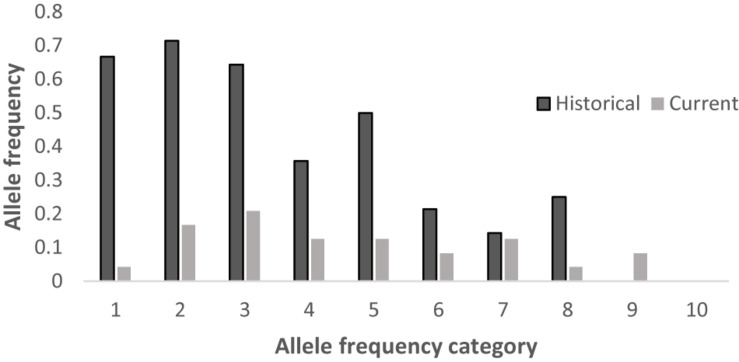
Distribution of allele frequencies for the historical and current populations across 8 loci.